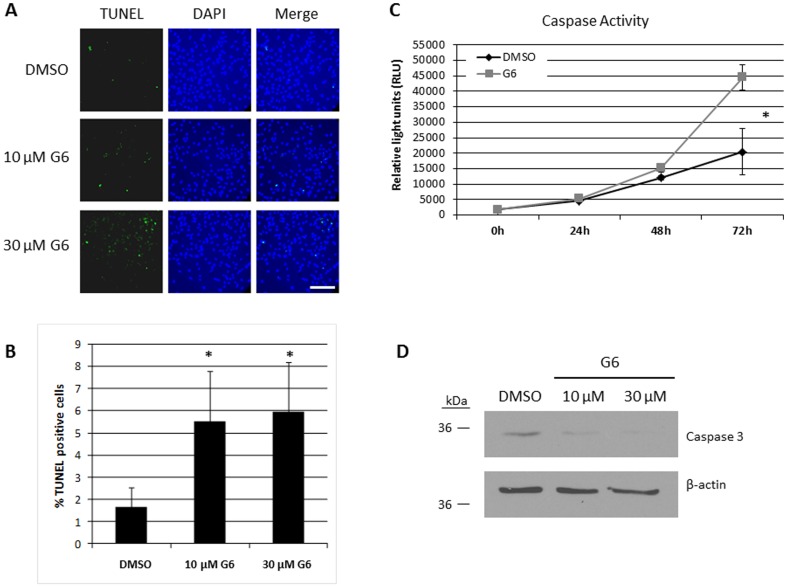
G6 induces caspase-dependent apoptosis in T98G cells.A) Cells were treated with G6 for 48 hours and apoptosis was examined by TUNEL immunofluorescence. Shown is one of three independent results. Scale bar = 50 µm. B) Quantification (n = 3) of the percentage of TUNEL-positive cells. *, p<0.05 vs. DMSO control treated cells as determined by ANOVA. C) Cells were treated for the indicated times with a 10 µM concentration of G6 and Caspase 3/7 activity was measured by a luminescent assay at the indicated times. Each point was measured in triplicate and shown is one of three independent experiments. A significant difference (*, p<0.05) was noted between the 72 hour time points as determined by ANOVA. D) Cells were treated with G6 for 48 hours and full length Caspase-3 expression was measured by Western blot. Shown is one of two representative blots.